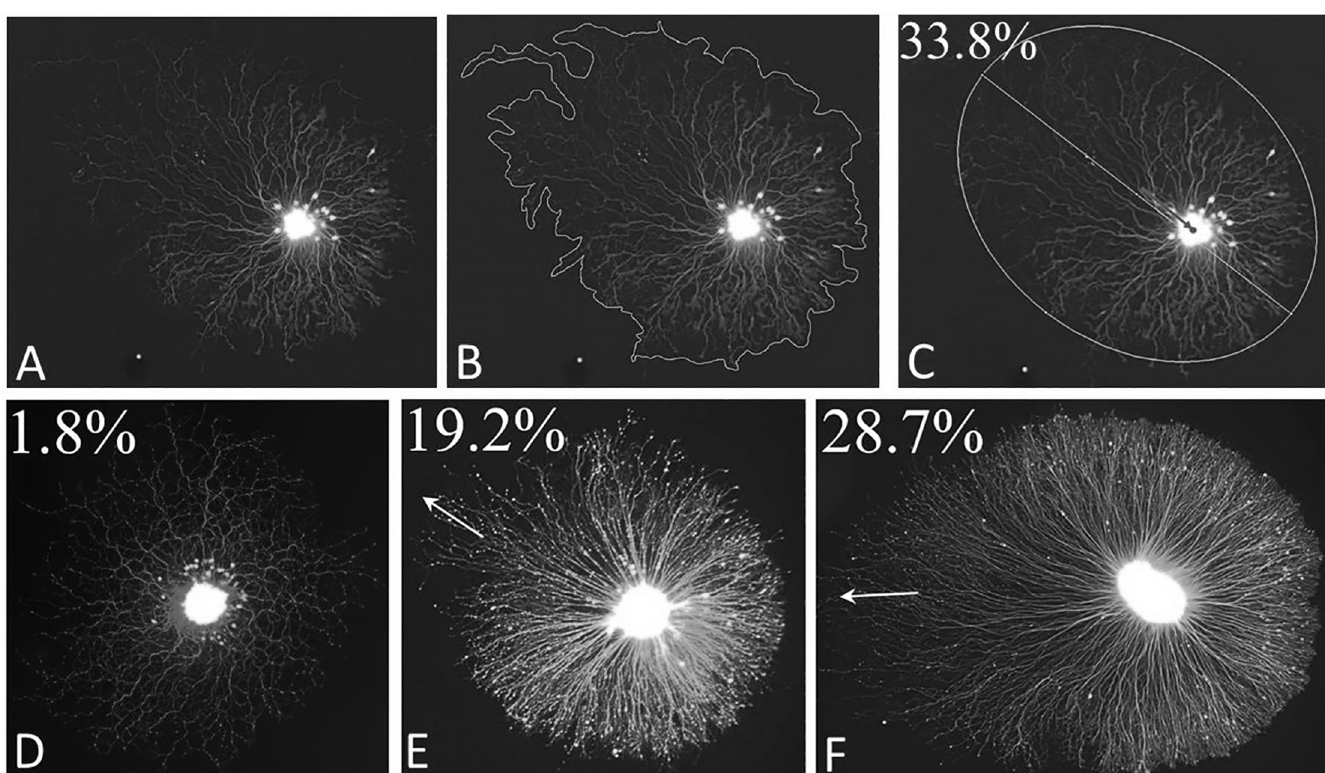
Fig 3. Quantification of the degree of neurite length asymmetry and its orientation. An example of the method is shown using the explant in panel A. A contour was drawn around the explant halo [B] and explant core [not shown] using the ImageJ Freehand selection tool. Using the “Fit Ellipse” tool, ellipses were fit to the halo [C] and the core [not shown]. The centers and major axis lengths of both ellipses were identified by the macro. The center of the explant core was compared to the distance from the halo center to the nearest end of the major axis [arrow in C]. The magnitude of neurite length asymmetry was taken to be the percent displacement of the core center from the halo center to the nearest end of the major axis [in this case, 33.8%]. Examples of other explants analyzed in this way are shown in D-F.